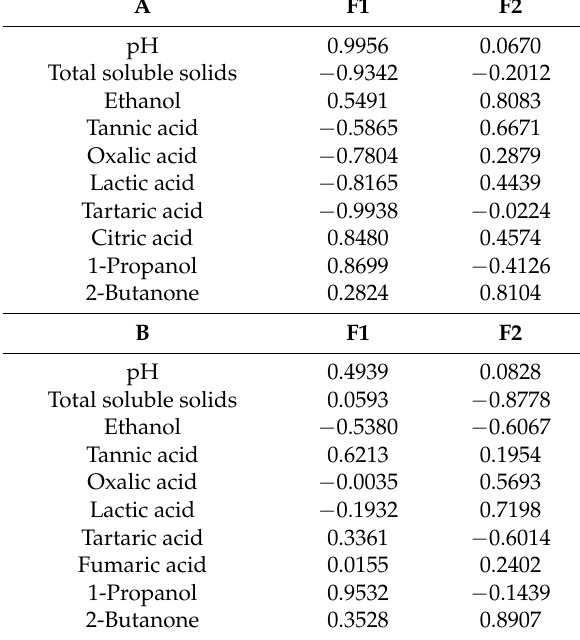
Table 5. The principal component loadings resulting from the principal component analysis of tchapalo stored at ( A ) ambient temperature (28 to 30 ◦ C) for four days and ( B ) 4 ◦ C for six